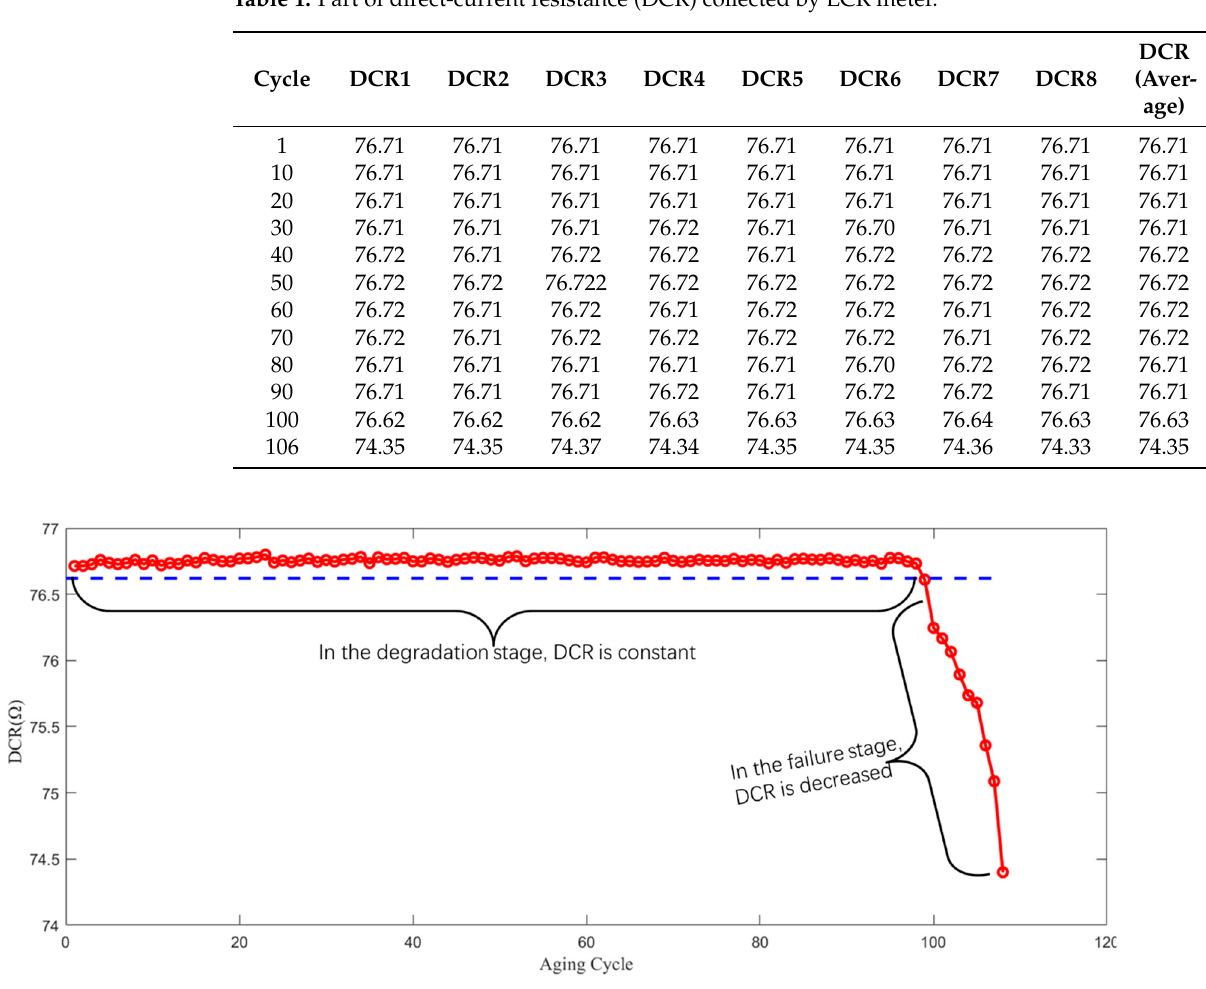
Figure 2. Experimental platform of the electromagnetic coil: Aging experimental platform is used for accelerated aging test at constant high temperature, experimental platform of data measurement is used to measure the electrical parameters of the electromagnetic coil. Table 1. Part of direct-current resistance (DCR) collected by LCR meter.